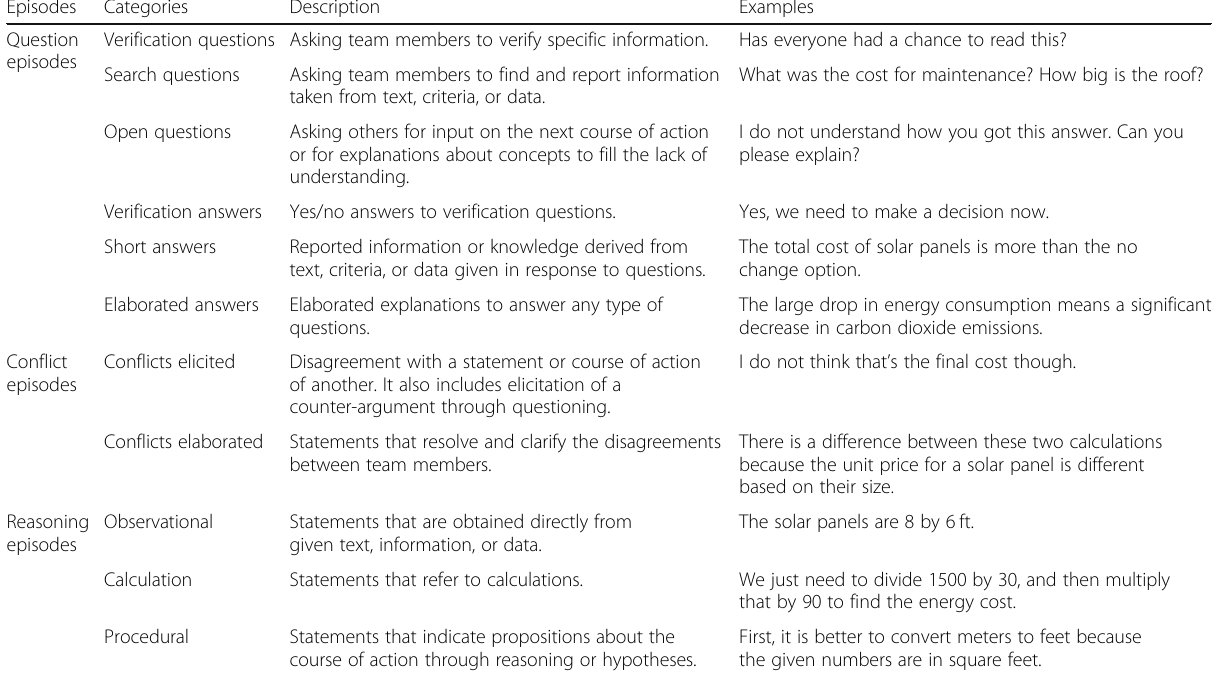
Table 1 The question-conflict-reasoning coding